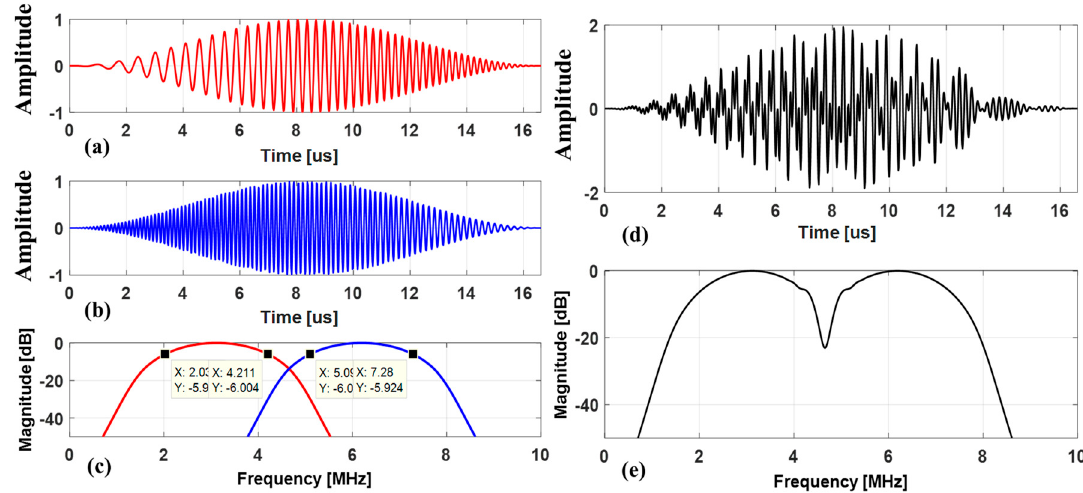
Figure 6. Time waveforms and frequency spectrums of frequency band divided two sub-band chirps with mutually orthogonal property. Time waveforms of ( a ) lower frequency band chirp-increasing linear FM over time (chirp1: c 1 ( t ) ) and ( b ) higher frequency band chirp-decreasing linear FM over time (chirp2: c 2 ( t ) ); ( c ) corresponding frequency spectrums of lower frequency chirp and higher frequency chirp; ( d ) transmission waveform of added two sub-band chirps; ( e ) the corresponding frequency spectrum of the added two chirps.